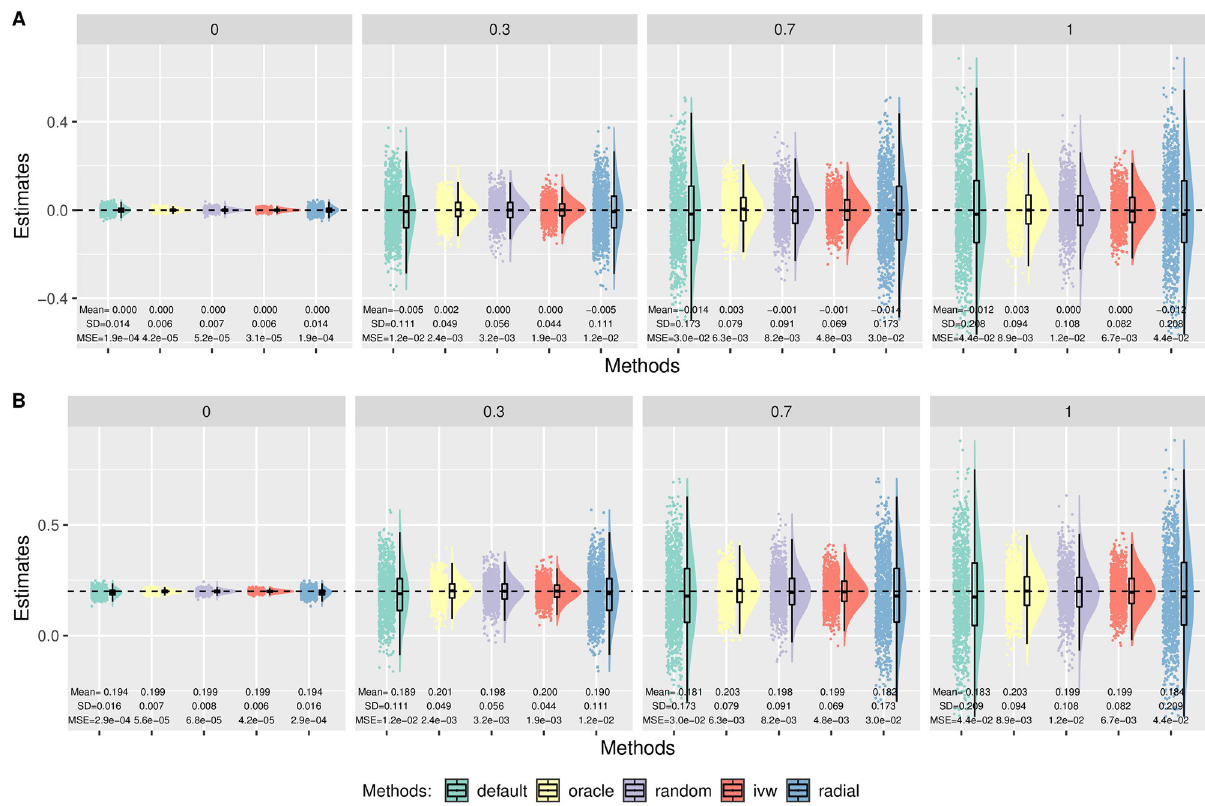
Fig 5. Simulation (b) results with balanced pleiotropy, n = 100 000, m = 100. Empirical distributions of the estimates of the causal effect θ by the methods. Each column corresponds to 0%, 30%, 70% or 100% invalid IVs. A: θ = 0. B: θ = 0.2.